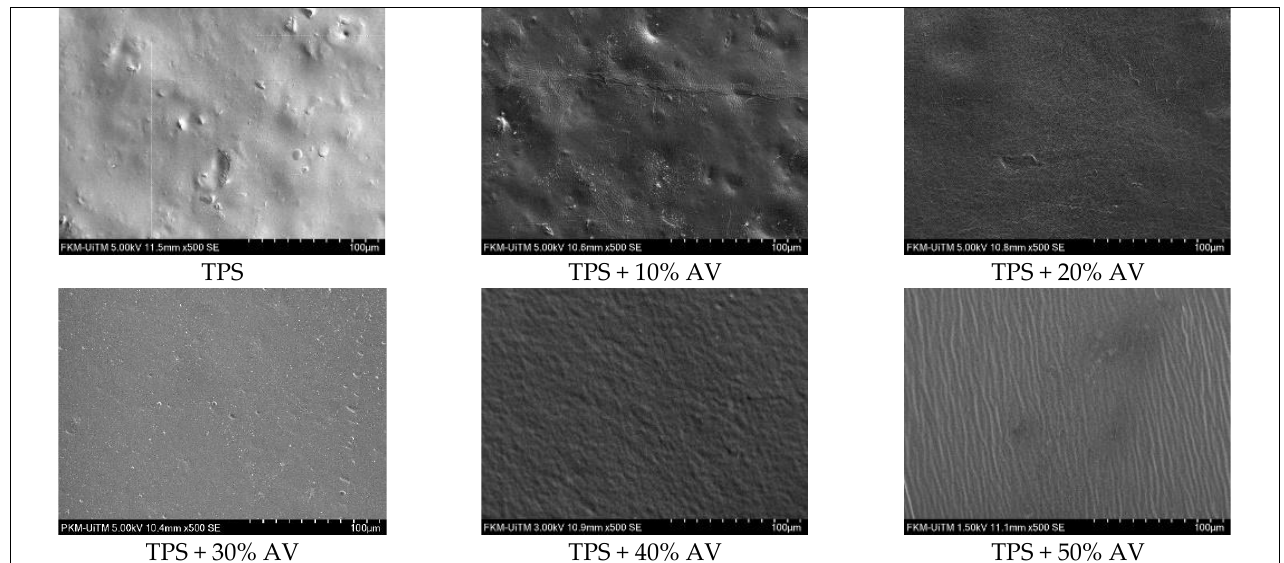
Figure 7. The morphological structure of TPS film with different AV gel concentrations at 500× mag- nifications. 500 ×